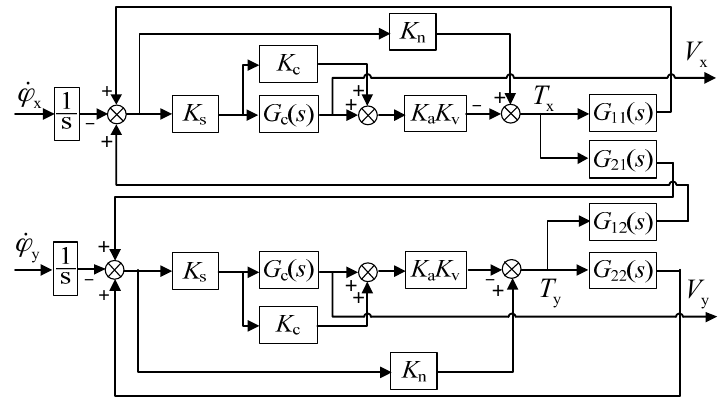
Figure 2. Block diagram of the rebalance loop without decoupling compensation.